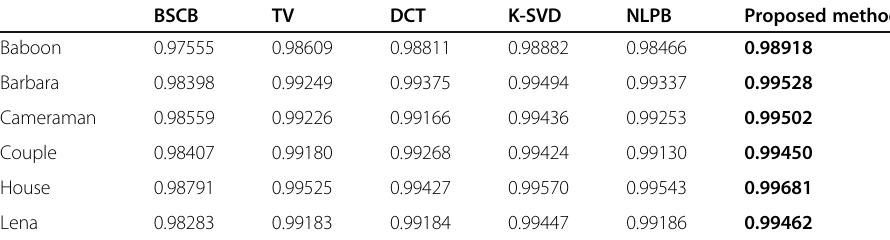
Table 2 The SSIM of each method for removing text coverage BSCB TV DCT K-SVD